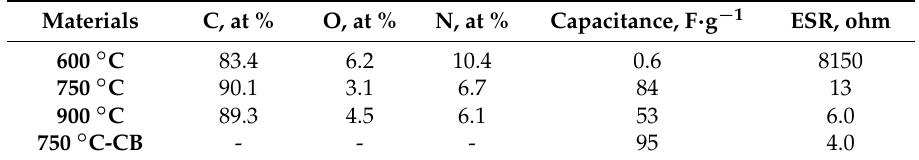
Table 2. Carbon composition as determined by XPS analysis and electrochemical capacitance extracted from cycling voltammetry curves.